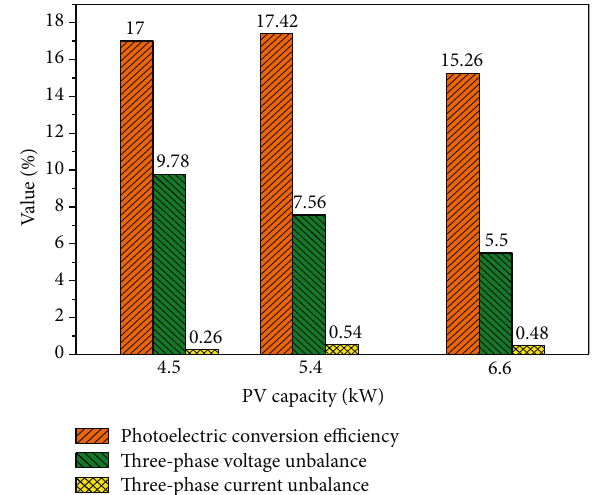
Figure 3: The electronic performance of the system is driven by di ff erent PV